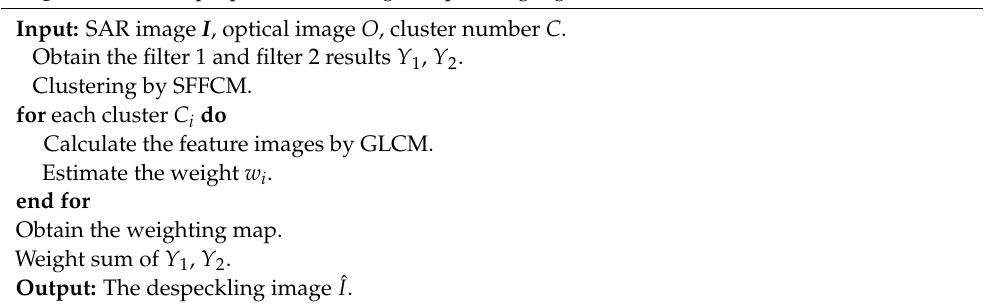
Algorithm 1 The proposed SAR image despeckling algorithm. Algorithm 1. The proposed SAR image despeckling algorithm.